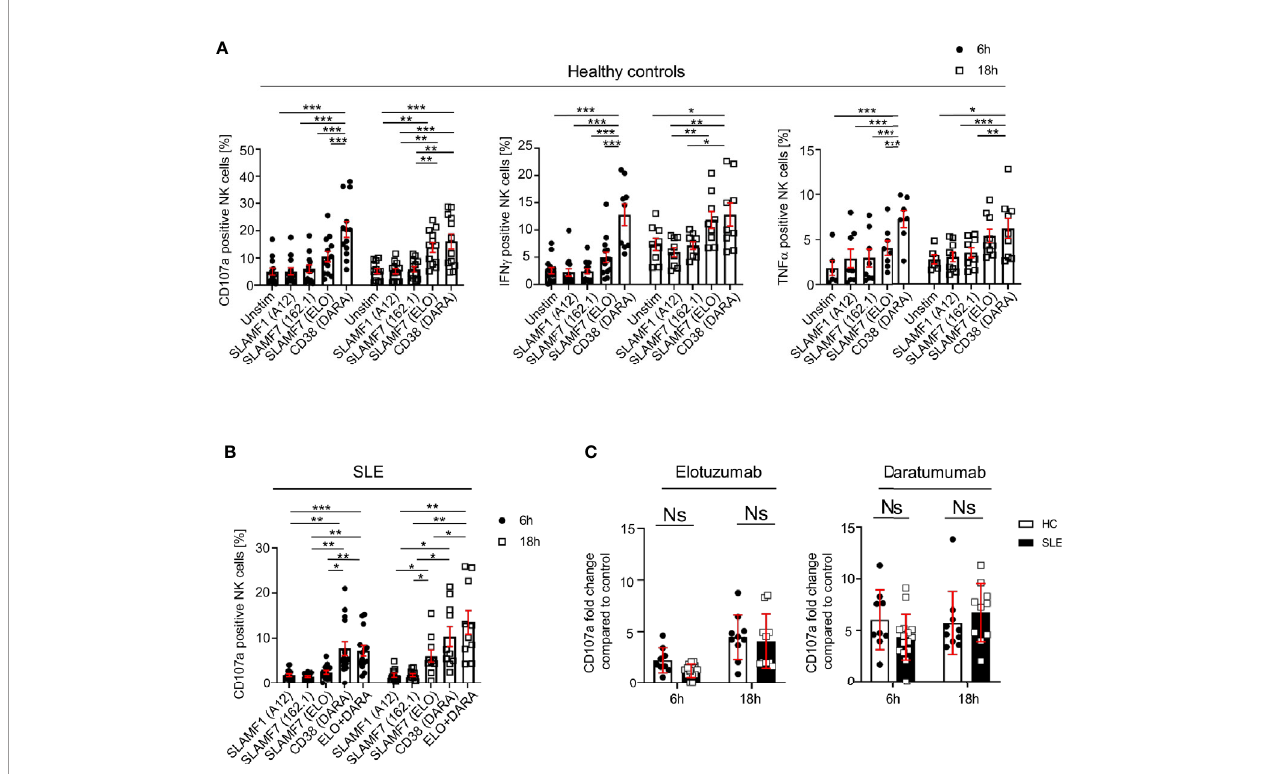
FIGURE 4 | Engagement of SLAMF7 and CD38 with speci fi c mAb enhances the function of healthy and SLE NK cells. (A) Degranulation (CD107a) and production of cytokines (IFN g and TNF a ) in NK cells of healthy controls after stimulation with daratumumab (N=14) and elotuzumab (N=12, Mixed-effect analysis with Tukey ’ s multiple comparison test). (B) Degranulation (CD107a+) in NK cells of SLE patients after stimulation with daratumumab (6h N=15, 18h N=10) and elotuzumab (6h N=14, 18h N=10; two-way ANOVA analysis and Sidak ’ s multiple comparison test). (C) Fold change of CD107a compared to control after 6h or 18h stimulation with elotuzumab or daratumumab in HC and SLE patients (HC 6h=9, HC 18h=10, SLE 6h=15, SLE 18h=10; mixed-effect analysis with Sidak ’ s multiple comparison). Data represent mean ± SEM (*P < 0.05, **P < 0.01, ***P < 0.001). HC, healthy